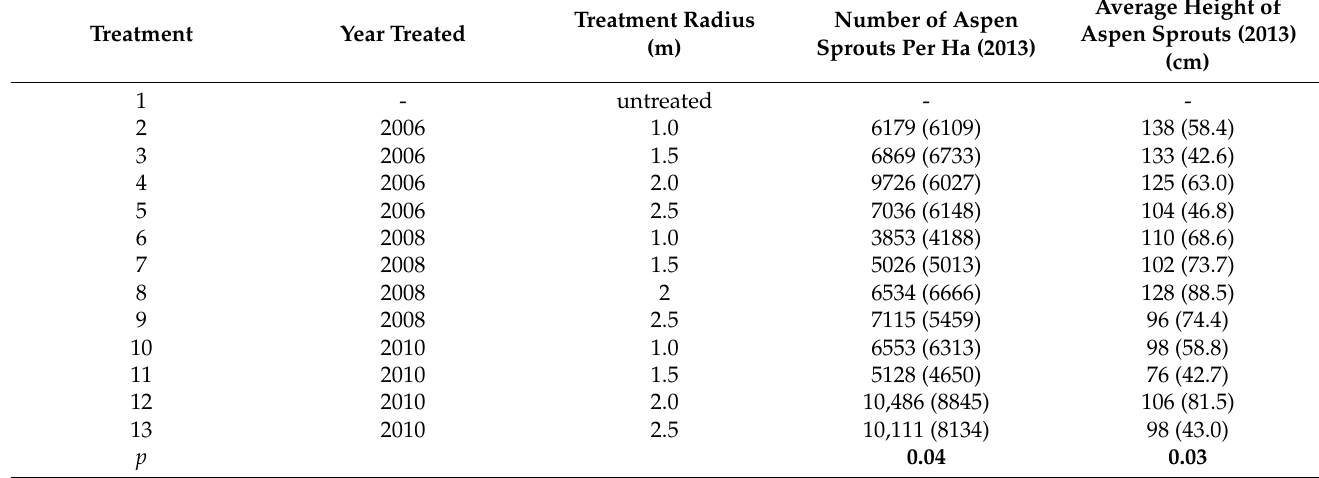
Table 4. Treatment effects on number and height of aspen sprouts within a 1 m radius plot centered on the crop spruce seeding for the 3 Lac LaBiche blocks in 2013. Despite ANOVA detecting a significant effect of treatments on aspen sprout number and height, Scheffe test did not indicate differences. Significant p values ( α = 0.05) are shown in bold.